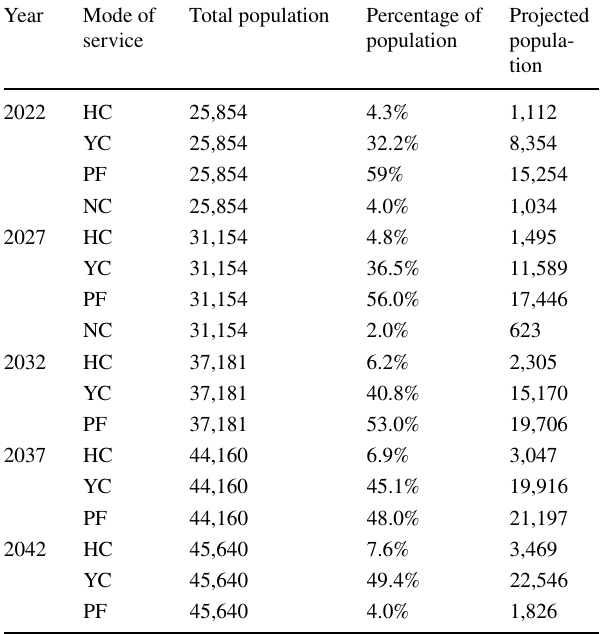
Table 4 Projected population by mode of service